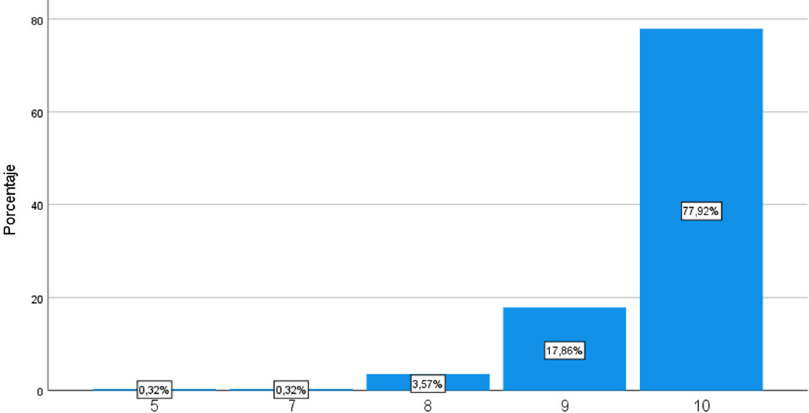
Fig. 1 Organizational quality (%). From: Data obtained from question no. 7 of the survey (closed, scaled, on a scale of 1: very bad to 10: excellent). Compiled by the authors through the SPSS. Table 2 Perception of the human resources available and responses of the coordination team on the master ’ s degree (%).